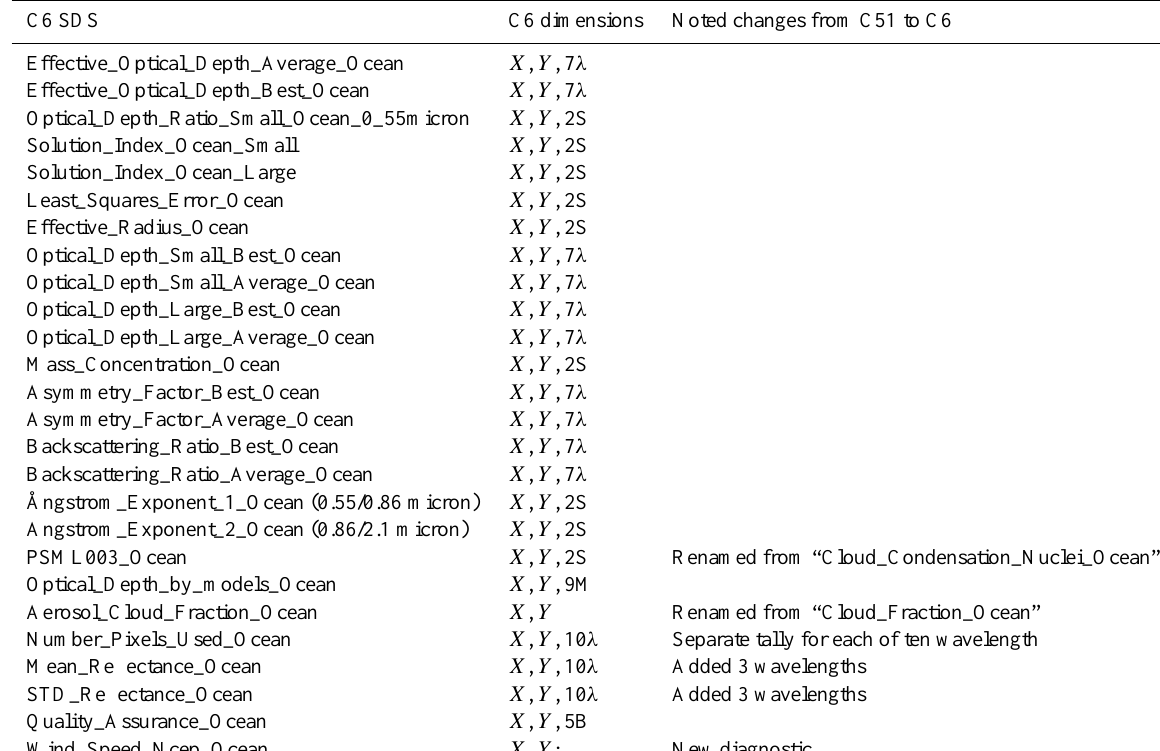
Table 3. C6 DT-ocean data products and changes from C51.